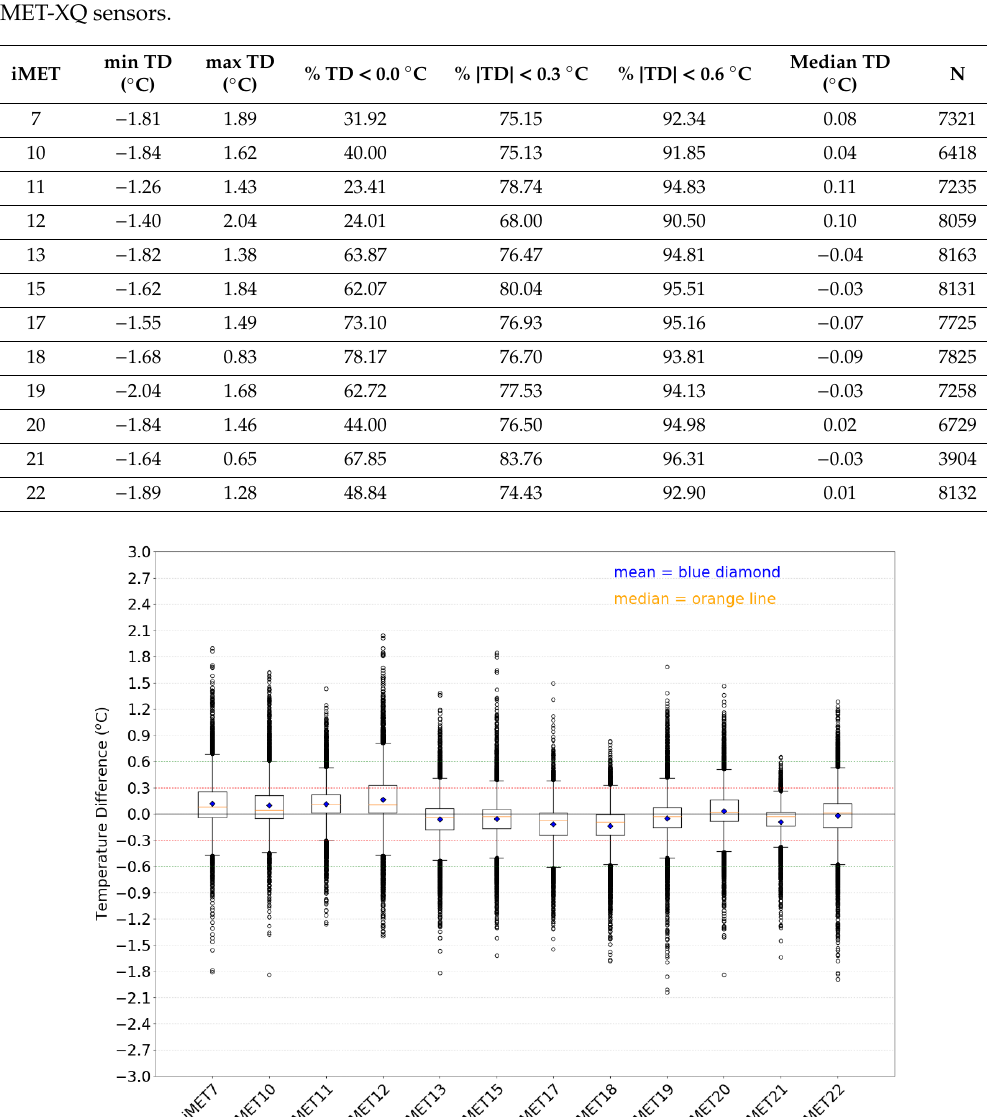
Figure 4. Temperature difference (°C) boxplots for each iMET-XQ sensor (x-axis) with all the other iMET-XQ sensors for the day-time tower experiments (i.e., the dusk experiments were excluded). The means are represented by blue diamonds, the medians are shown by orange lines. A temperature difference of ±0.3 °C is marked by a red dotted line. A temperature difference of ±0.6 °C is marked by a green dotted line.